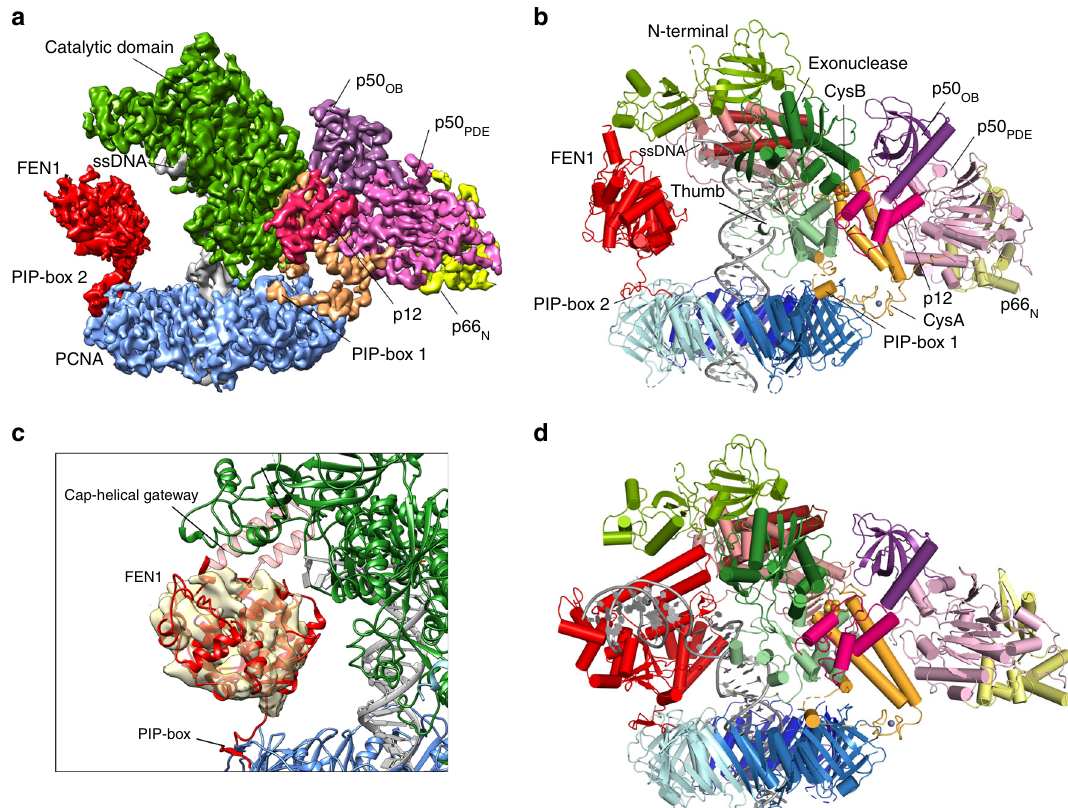
Fig. 5 Cryo-EM structure of the Pol δ – DNA – PCNA – FEN1 complex. a Cryo-EM map of the complex colored by domains. b Complex model colored by domains. c Close-up showing the map region around FEN1 fi ltered to 6 Å resolution. d Proposed toolbelt model for Pol δ and FEN1 bound to PCNA processing an Okazaki